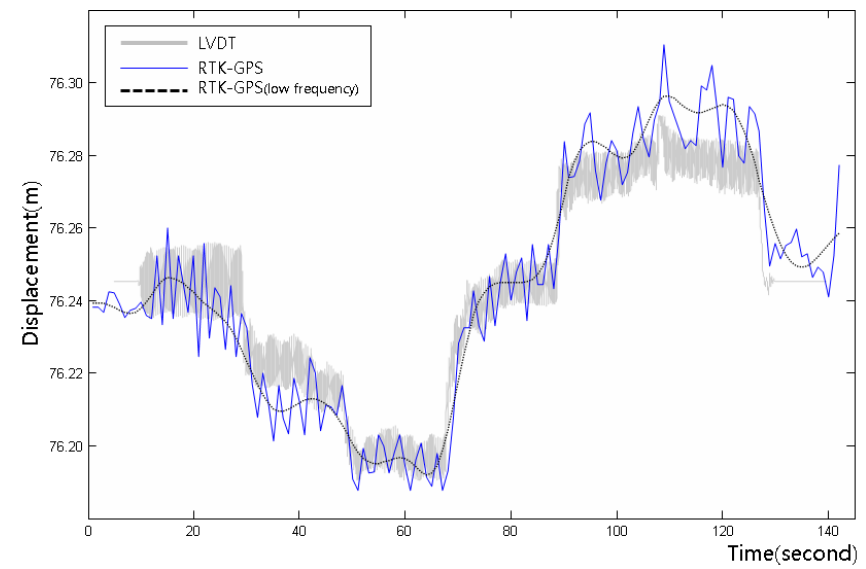
Figure 17. LVDT and RTK-GPS measurements and low-frequency displacements extracted from the RTK-GPS measurements.